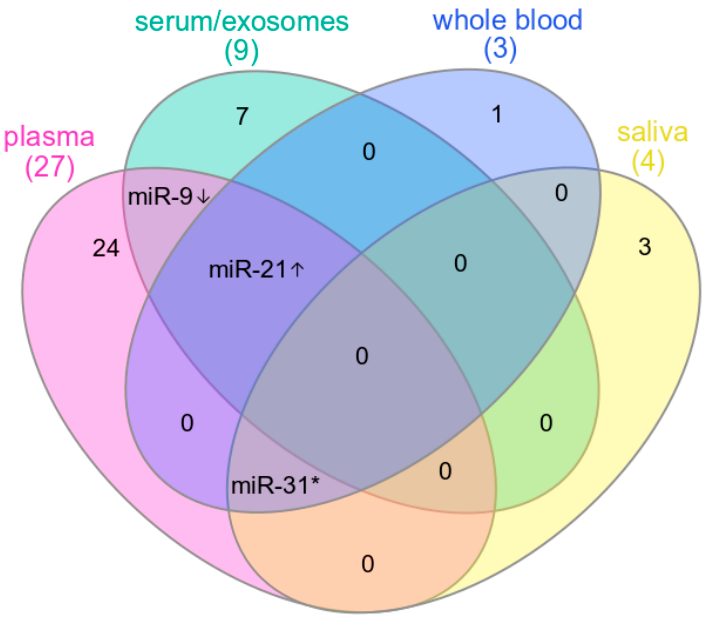
Figure 1. Extracellular miRNAs implied as biomarkers in HNSCC. miRNAs that appeared in studies investigating different biofluids are listed in the figure. ↑ —miRNAs for which higher level was associated with worse prognosis; ↓ —miRNAs for which lower level was associated with worse prognosis; * —miRNAs with discordant results between studies.